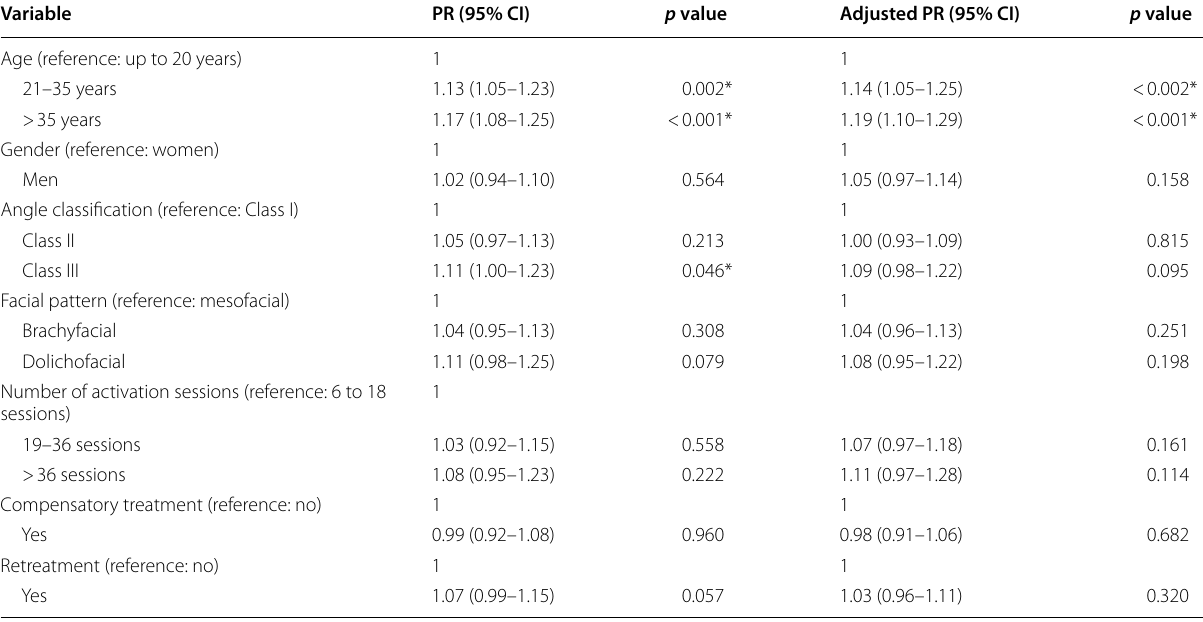
PR prevalence ratio, CI confidence interval *Significant difference (Poisson regression model, p <